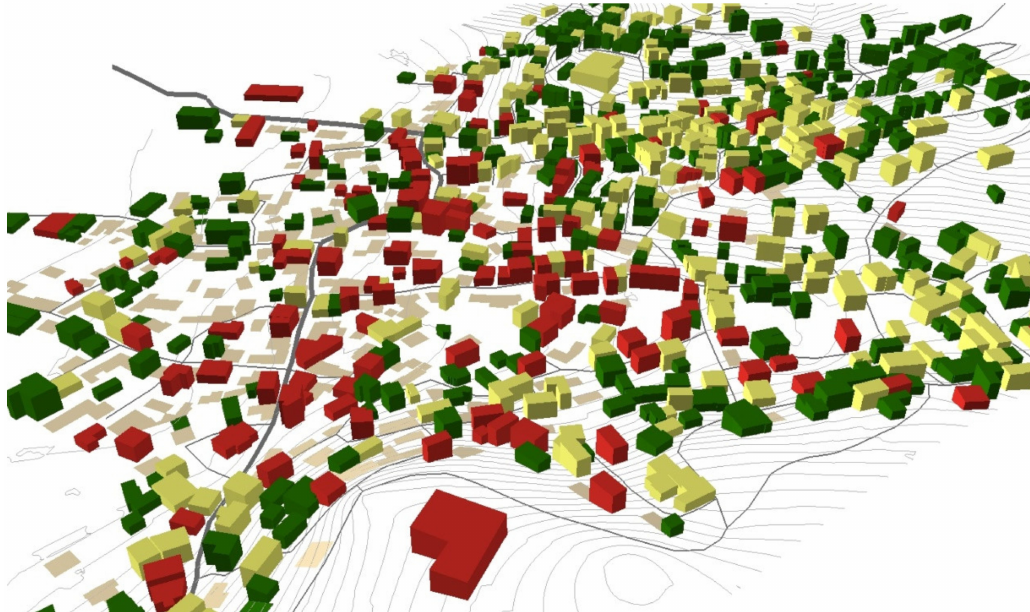
Figure 13. Three-dimensional map of the Vrisa traditional settlement presenting the result of the demolition process during the last few months. Color presents the damage category of the remaining buildings, while demolished buildings are presented as